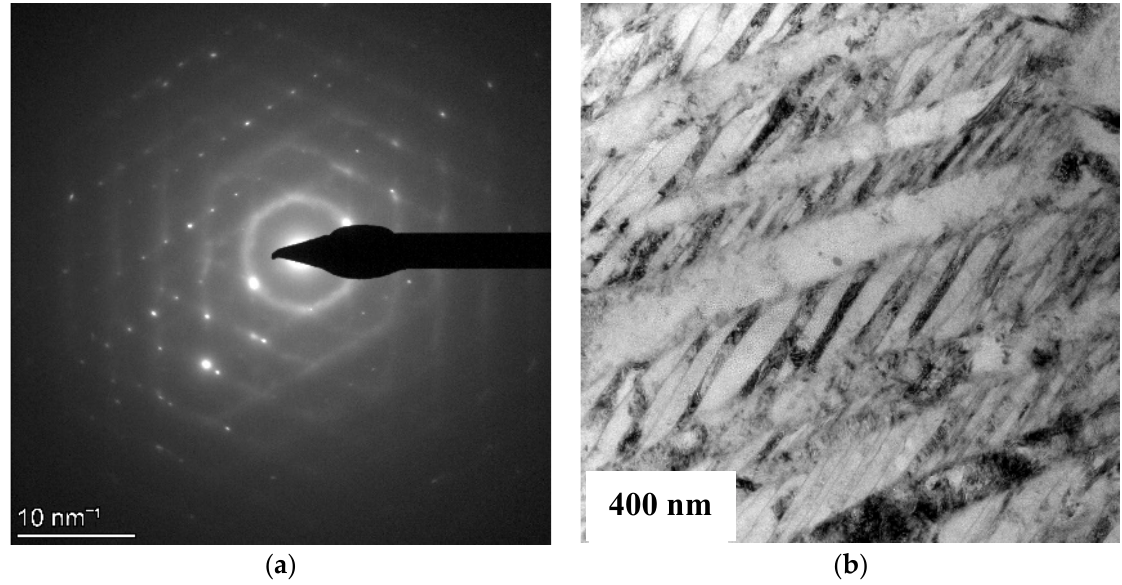
Figure 8. ( a ) Selected area diffraction pattern of Nitinol peened at 9 GW/cm 2 showing fragmented and spotted rings. ( b ) Bright field TEM micrograph of Nitinol peened at 9 GW/cm 2 showing a lamellar structure with primary and secondary lamellae. Also evident in these lamellae was the high amount of stored plastic deformation.